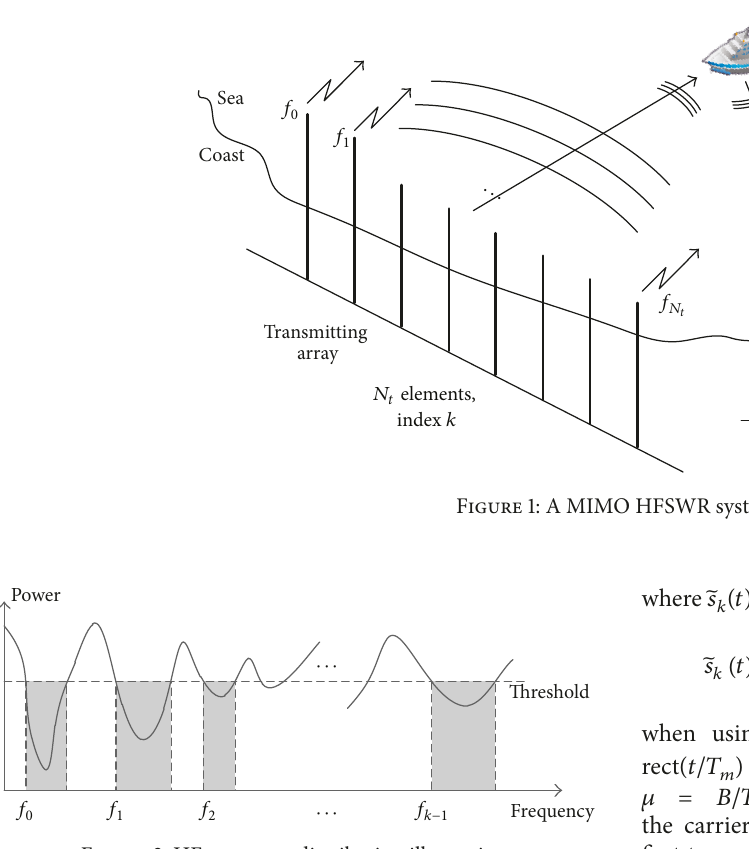
Figure 2: HF spectrum distribution